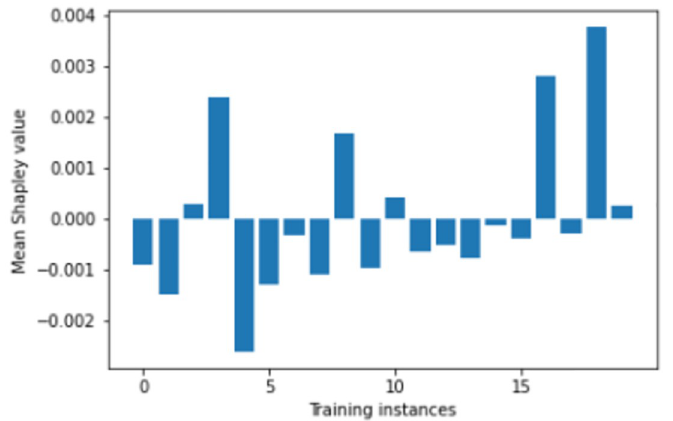
Fig 8. Estimation of input attribution for “MoteStrain” dataset.